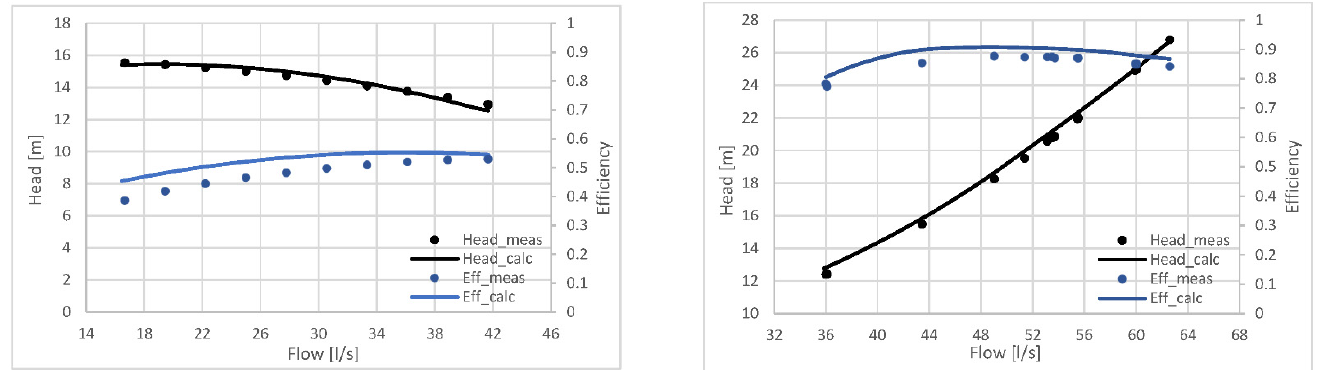
Figure 12. ( A ) Head and efficiency for the PAT 100-200 (nst = 43.48) in pump operation. ( B ) Head and efficiency for the PAT 100-200 (nst = 35.91) in turbine operation.